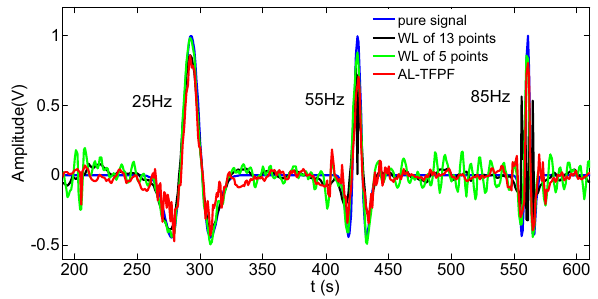
Fig. 7 Results of TFPF with different WLs and AL-TFPFs